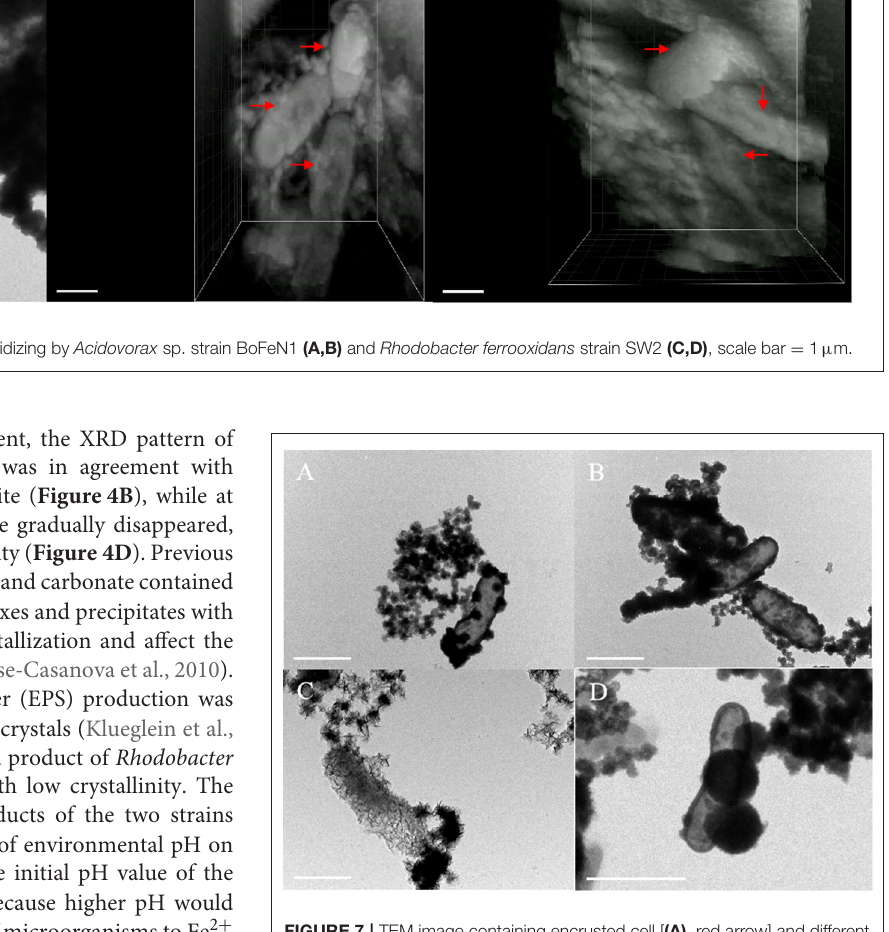
FIGURE 7 | TEM image containing encrusted cell [ (A) , red arrow] and different perspective images of FIB/SEM tomography (B,C) with fully and partially encrusted cells (red arrow), scale bar = 1 µ